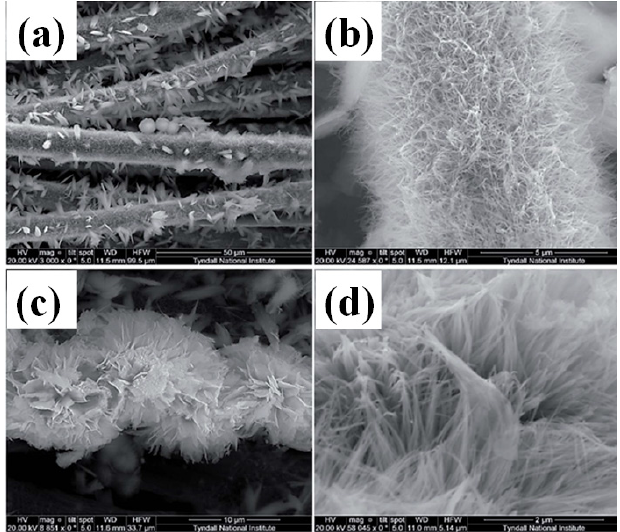
Figure 9. ( a ) Illustration of the preparation of Co 3 O 4 @SBA-15 supercapacitor electrode materials, showing (i) carbon nanomembrane (dark gray) formation on the walls (gray blue) of SBA-15 and (ii) incorporation of Co 3 O 4 clusters into the cylinder type mesochannels and ( b ) cycle life of Co 3 O 4 (66%)@SBA-15 electrode material at a scan rate of 0.1 V·s − 1 [65].